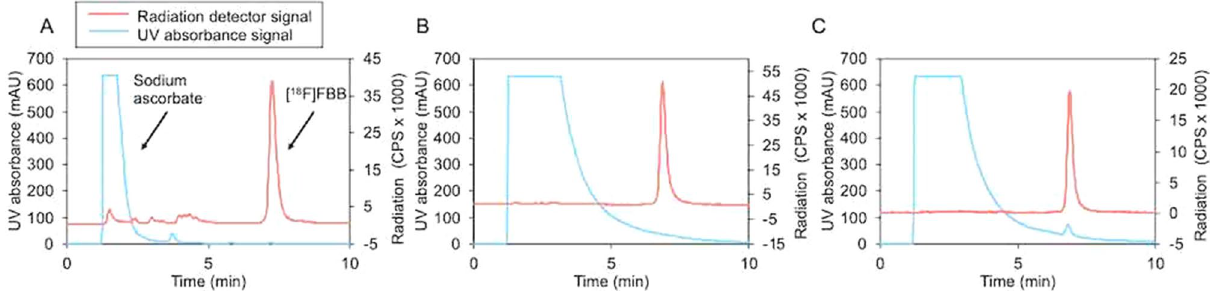
Figure 8. Example HPLC chromatograms for [ 18 F]FBB. ( A ) Crude product. ( B ) Formulated product. ( C ) Formulated product co-injected with reference